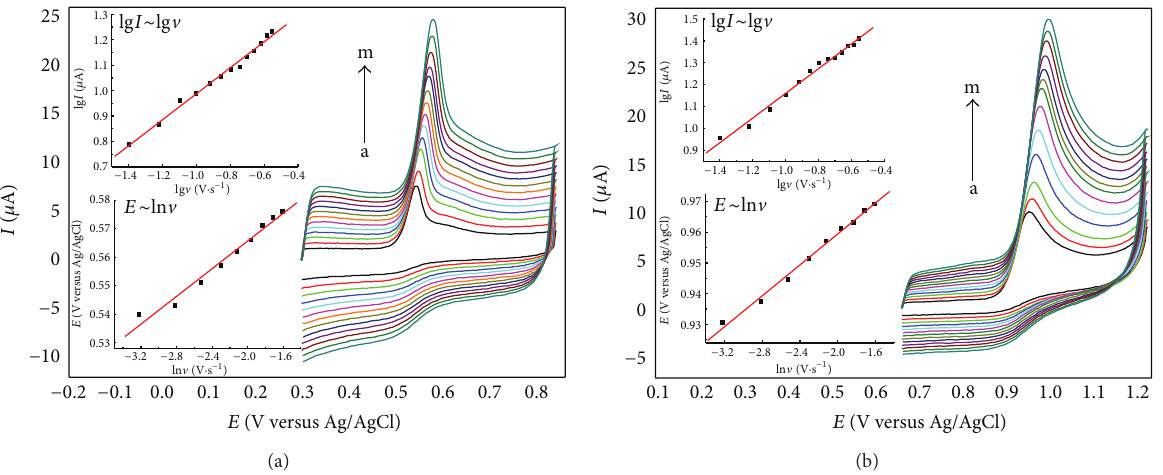
Figure 7: CVs for UA (a) and Xa (b) at different scan rate in PBS (pH 3.0). Insets show the calibration plots of lgI-lgv and E-lnv . From a to m: 0.04, 0.06, 0.08, 0.10, 0.12, 0.14, 0.16, 0.18, 0.20, 0.22, 0.24, 0.26, 0.28.